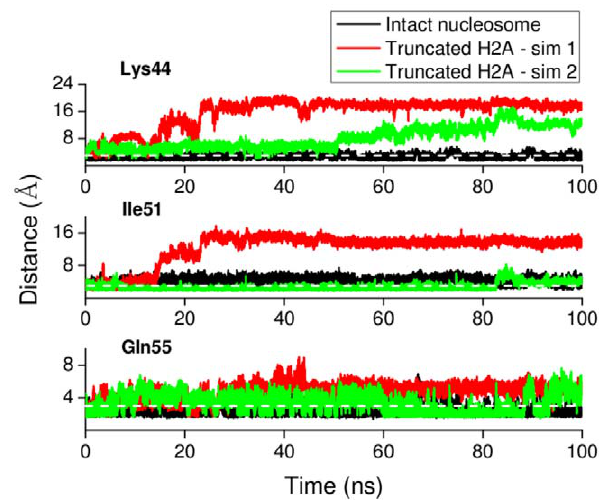
Figure 13. Interaction of close contact residues from Fig. 11, located near the region where H2A C terminus contacts the dyad, for intact and truncated H2A simulations. The minimum distances between any atom of Lys44, Ile51 or Gln55 and the closest residue on the H2A C terminus (Leu116, Leu115 and Asn110, respectively) are plotted as a function of time. The white line (dotted) indicates the distance (3 A ) below which residues can be regarded to be in close contact.